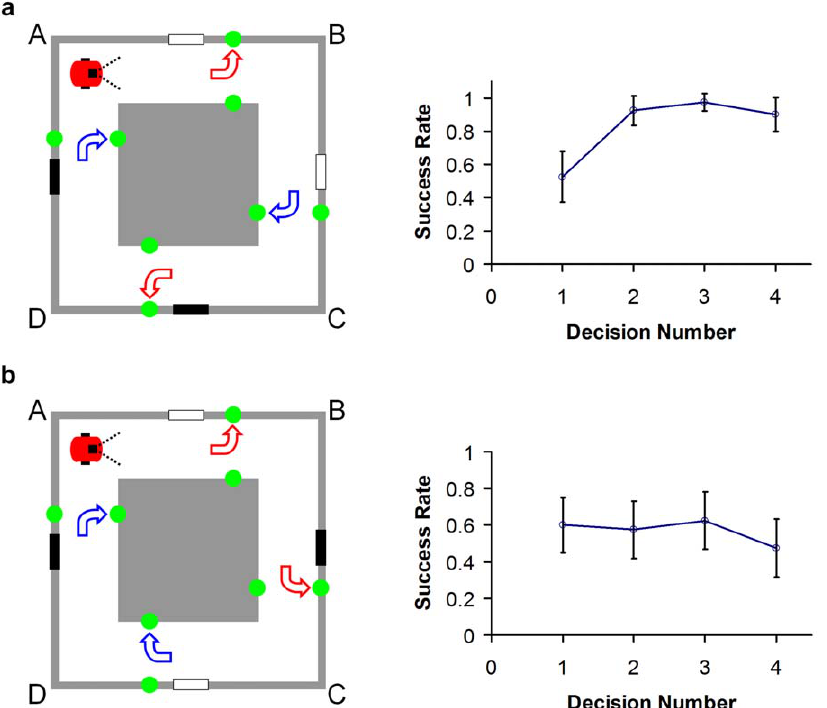
Figure 7. Robot behavioral performance in environments of varying perceptual ambiguity. (a) ‘‘Semi-ambiguous’’ corridor arena cue configuration. Reward directions specified during exploration and improving robot performance after replacement at choosing the correct reward direction. At the first decision point, by which time the robot has only seen one cue, performance is at chance. By the second decision point and beyond, however, the robot chose correctly approximately 90% of the time. (b) ‘‘Completely ambiguous’’ corridor cue configuration. Reward directions and steady robot performance with a theoretically indistinguishable cue configuration. Error bars show 95% confidence intervals. The robot performed no better than at